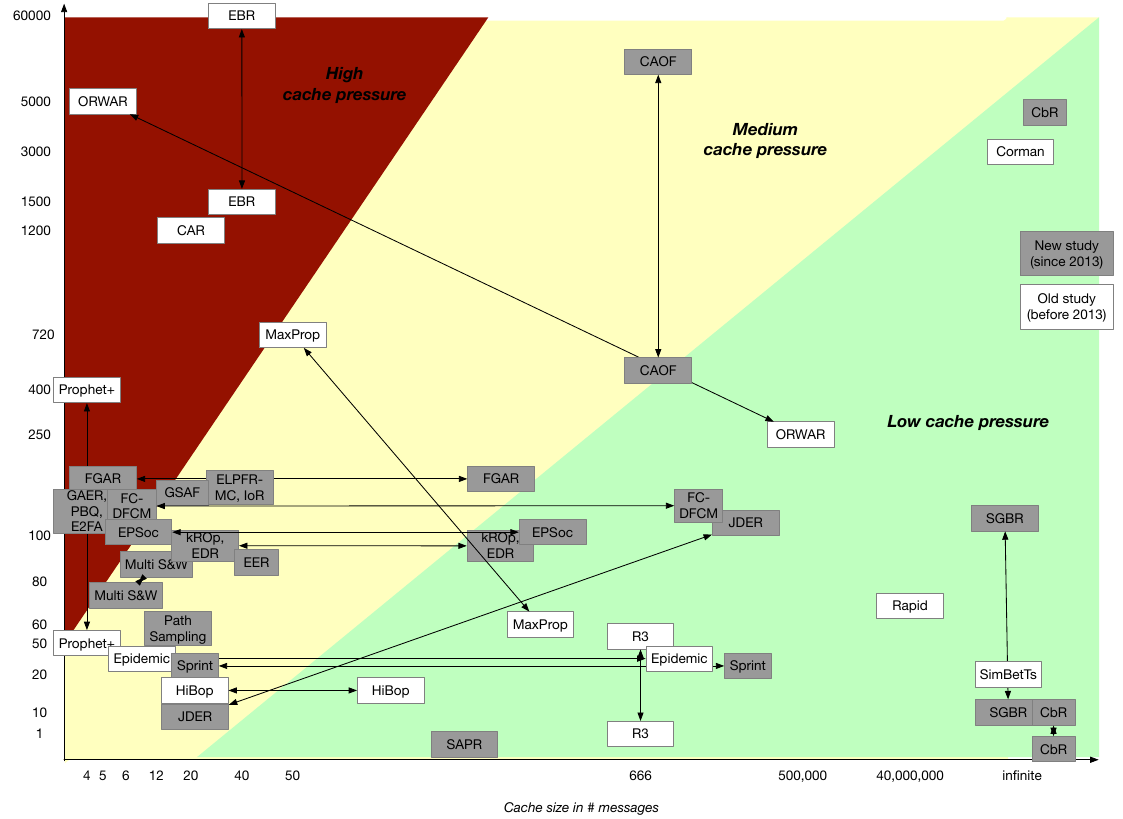
Figure 8. Cache sizes against network-wide traffic. Not all studies provide sufficient details, thus only a subset is